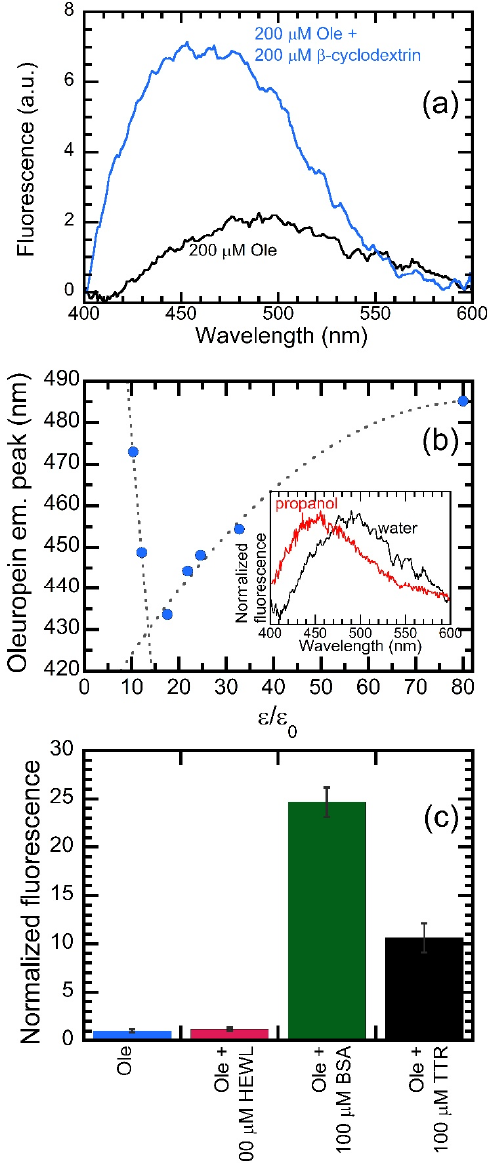
Figure 5. Biophysical characterization of the fluorescence emitted by OleA. ( a ) Fluorescence spectra of 200 µM OleA recorded in water in the absence (black) or in the presence (blue) of 200 µM β- cyclodextrin. ( b ) OleA emission peak as a function of solvent relative permittivity (ε/ε 0 ). The inset shows a comparison between the OleA emission spectra recorded in water (ε/ε 0 = 79.4) (black) or in propanol (ε/ε 0 = 21.8) (red). ( c ) Comparison of total OleA fluorescence intensity measured in the presence of 100 µM hen egg white lysozyme (HEWL), bovine serum albumin (BSA), or wt-TTR.